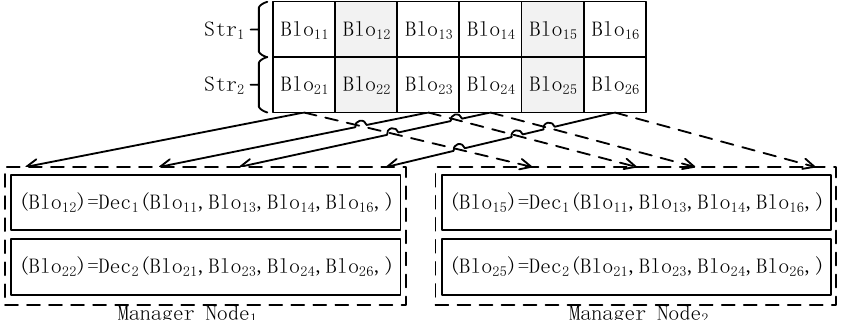
Figure 2. Transmission and Repair Process in Multi Manager Repair (MMR).